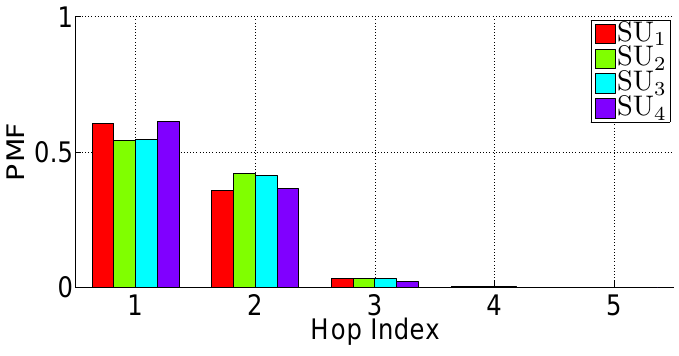
Figure 22. PMF of the hop index at which DATA messages are received in Scenario